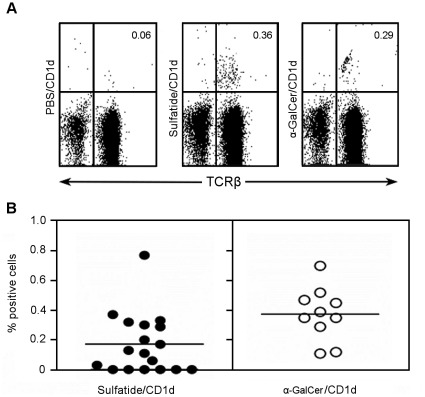
Sulfatide-reactive Type II NKT cells are enriched in the PLN during the development of T1D.PLN lymphocytes isolated from the pancreas of female NOD mice (6–20 week-old) were stained with sulfatide/CD1d-, aGalCer/CD1d- or unfilled PBS/CD1d-tetramers and anti-TCRb and then analyzed by flow cytometry. (A) The numbers shown in each panel indicate the % tetramer+ cells. (B) The scatter plots show the mean values of sulfatide/CD1d-tetramer+ (0.17%) and αGalCer/CD1d-tetramer+ (0.37%) cells in diabetic NOD mice (6–20 week-old). Note that we were not able to detect any correlation between NKT cell numbers and the severity of T1D, as we did not find any significant correlation between the frequency of sulfatide-CD1d-tetramer+ cells in diabetic vs. non-diabetic NOD mice.